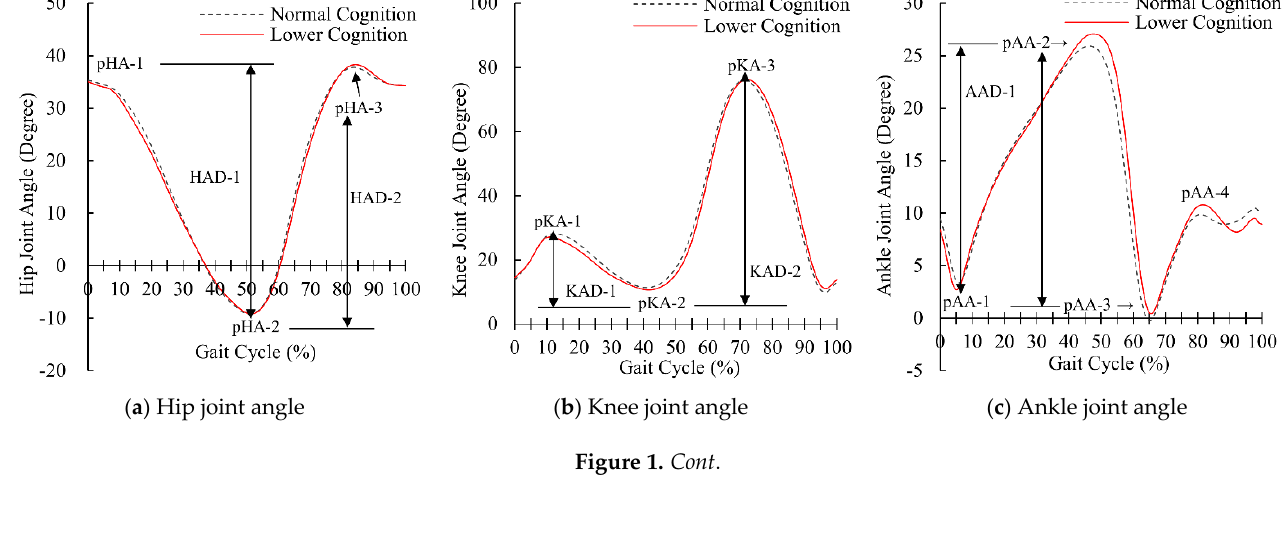
Table 3. Differences of the subdivisions of gait cycles between the normal cognition group and lower cognition group. Groups